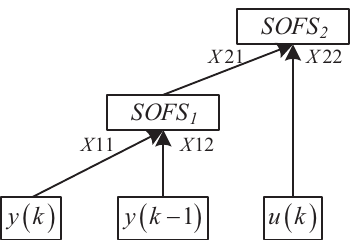
Figure 2. The structure of the DHSOIT2FS in 4.1.